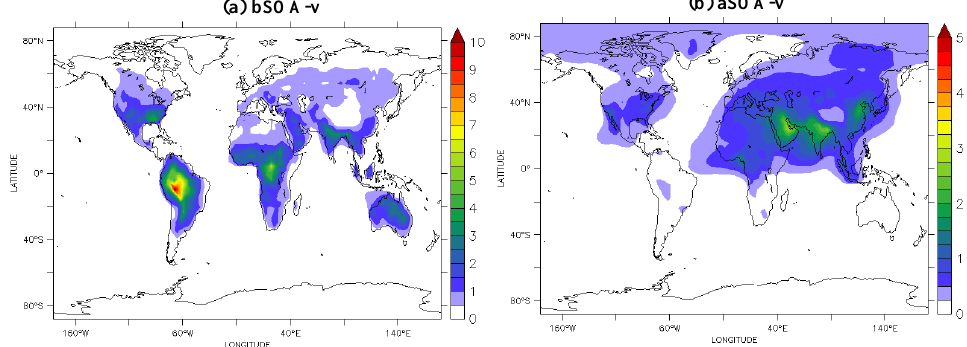
Figure 8: Modeled average surface concentrations (in μg m -3 ) of (a) SOA-v from the oxidation 1267 Figure 8. Modeled average surface concentrations (in µgm − 3 ) of (a) SOA-v from the oxidation of biogenic VOC emissions (bSOA-v) and of biogenic VOC emissions (bSOA-v) and (b) SOA-v from the oxidation of anthropogenic VOC 1268 (b) SOA-v from the oxidation of anthropogenic VOC emissions (aSOA-v) during the years emissions (aSOA-v) during the years 2005-2009. 1269